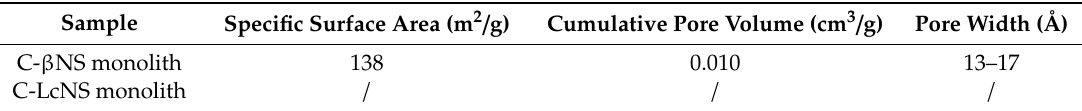
Table 4. Specific surface area, cumulative pore volume, and pore width of the C- β NS C-LcNS with no purification after the